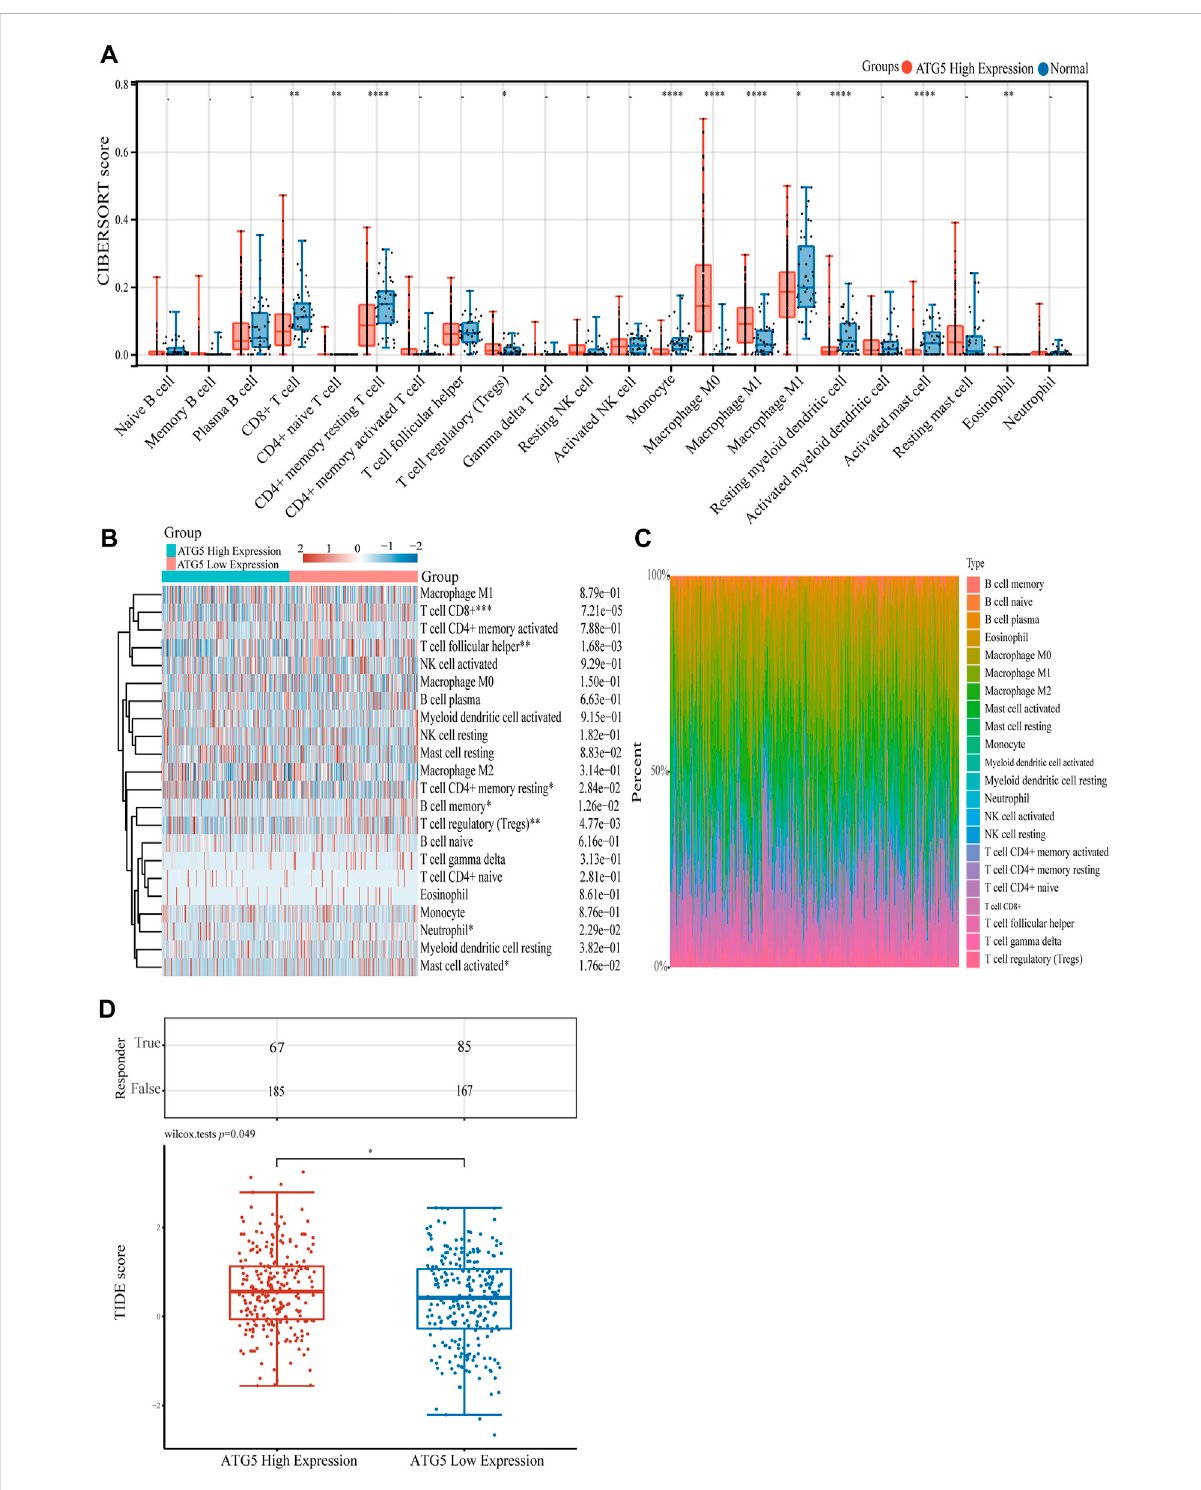
FIGURE 5 The relationship of ATG5 expression with immune cell in fi ltration. (A) The expression distribution of CIBERSORT immune score in ATG5 high expression HNSCC samples and normal samples. (B) Immune cell score heatmap of ATG5 high expression and ATG5 low expression in HNSCC samples. (C) The percentage abundance of tumor in fi ltrating immune cells between ATG5 high expression and ATG5 low expression HNSCC samples. (D) The distribution of immune response scores in ATG5 high expression and ATG5 low expression HNSCC samples in the prediction results. * p < 0.05, ** p < 0.01, *** p <